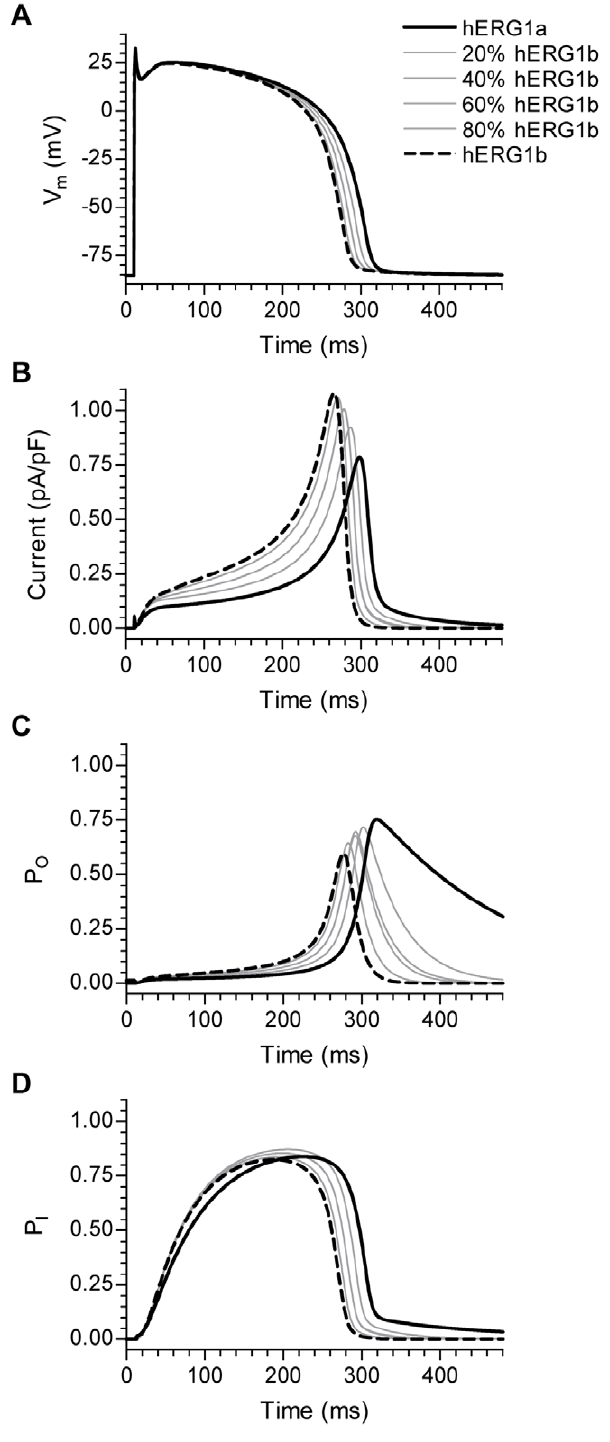
Figure 5. Action potential duration is modulated by the relative abundance of hERG1a and hERG1b. A, Steady-state action potentials simulated by the modified ten Tusscher (TTF) model paced at a basic cycle length (BCL) of 1000 ms. The transition rates of hERG1 channel activation ( a 3 ), deactivation ( b 3 ) and recovery from inactivation ( b 4 ) were modified to represent a gradual increase in the relative abundance of hERG1b (see table S2 for details). B, Simulated I Kr corresponding to the action potentials shown in A. Legend is the same as in A. C and D, Channel state occupancy during the action potential is shown for the open and inactivated states respectively. Legend is the same as in A.